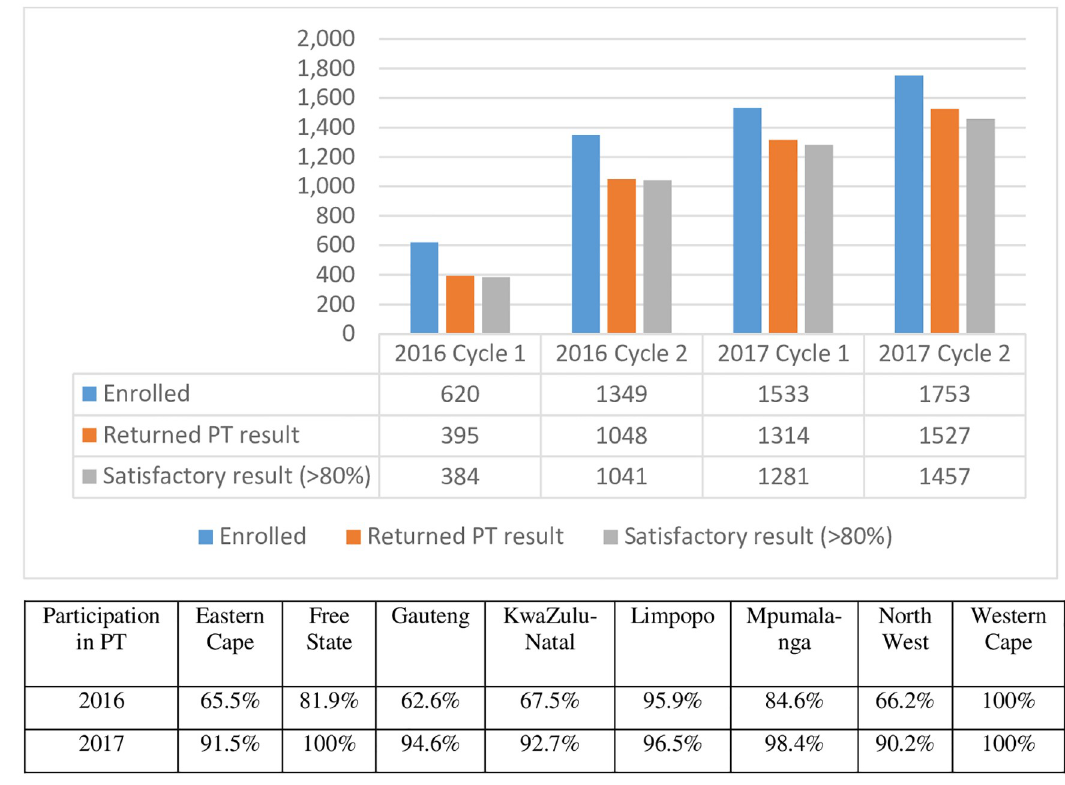
Fig 1. Results of proficiency testing (PT) scheme in 2016 and 2017, South